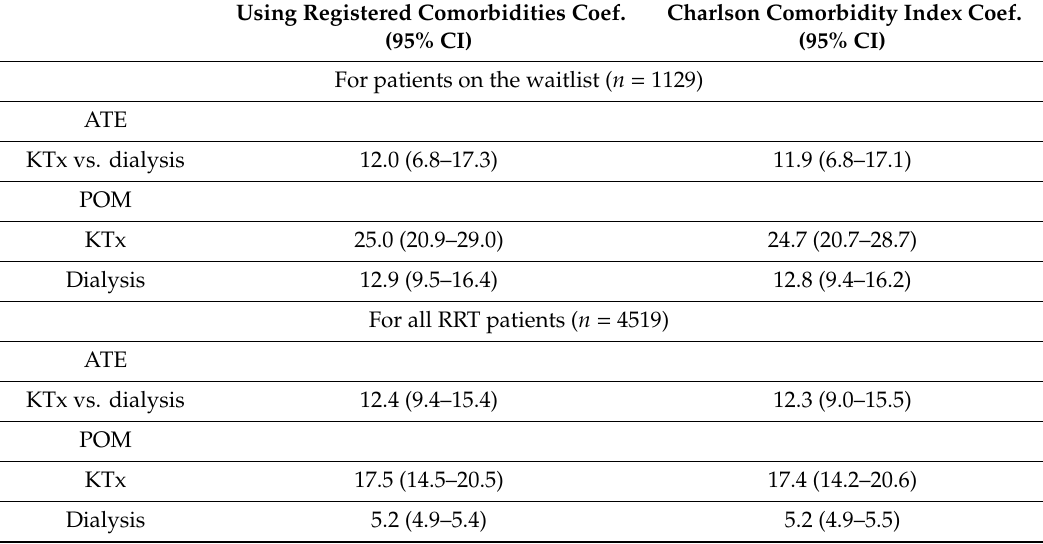
Table4. Sensitiveanalysis: averagetreatmente ff ectforRegionSkåneandStockholmusingcomorbidities registered in the SRR and while controlling for the Charlson comorbidity